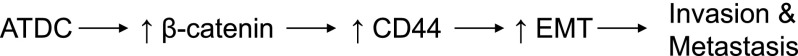
Proposed model for the contribution of ATDC to pancreatic cancer development and progression. Flow chart describing a novel signaling pathway by which ATDC drives EMT and invasion during pancreatic tumorigenesis by β-catenin-mediated up-regulation of CD44.